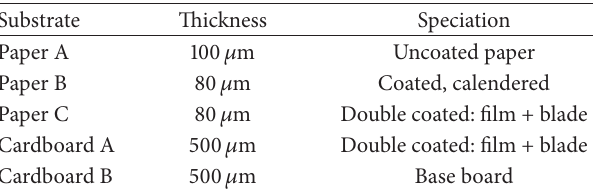
Table 2: Substrate properties.